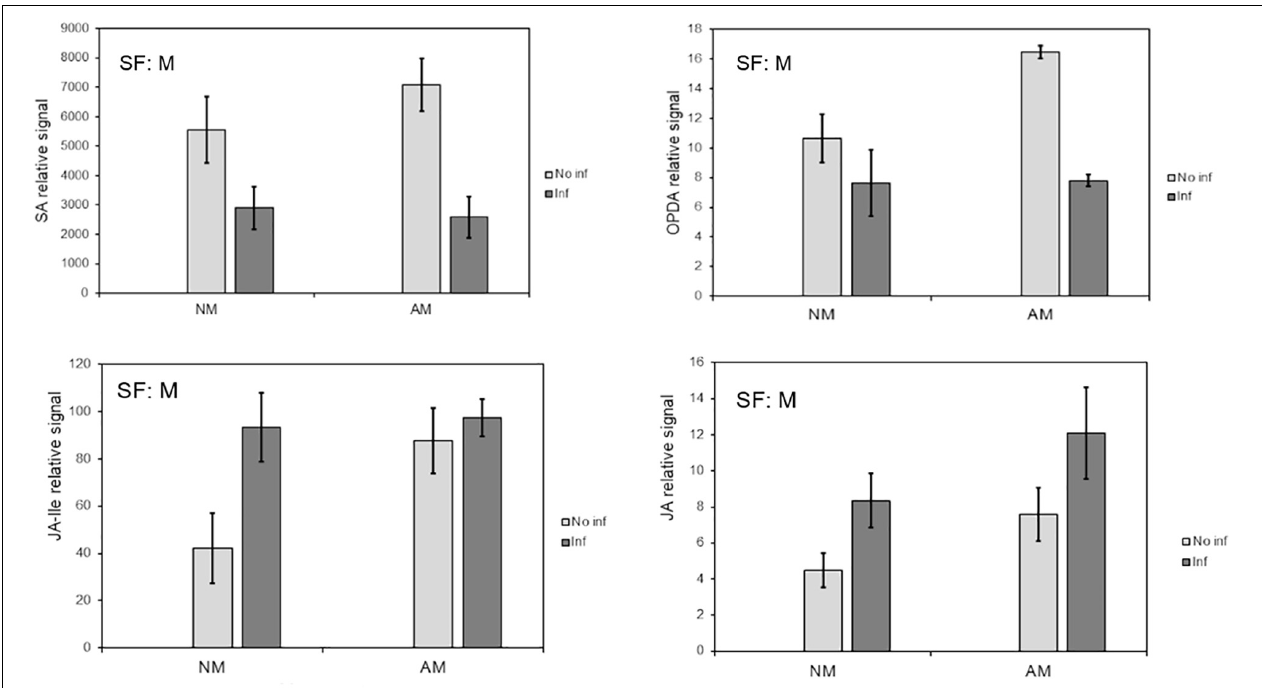
FIGURE 3 | Influence of mycorrhization on phytohormones that regulate plant defence against T. urticae infestation. Content of the defense-related phytohormones OPDA, SA, Me-JA and JA in local leaves from mycorrhizal and non-mycorrhizal C. aurantium plants at 48 h post infestation. The levels were obtained from the non-targeted metabolome analysis by UPL-QTOFMS. Four treatments were compared: NM: non-mycorrhizal non-infested plants. AM: mycorrhizal non-infested plants. NM inf: non-mycorrhizal infested plants. AM inf: mycorrhizal infested plants. Three independent and two technical replicates were randomly performed. Significant factors (SF) indicate if the two independent factors: A (Arbuscular Mycorrhizal), M (Mite infestation) and/or their interaction I (A × M) were statistically significant (Two-way ANOVA, P < 0.05). The stats of analysis are provided in Supplementary Table 1 . Data was presented as a mean of five replicates ± SD (n =